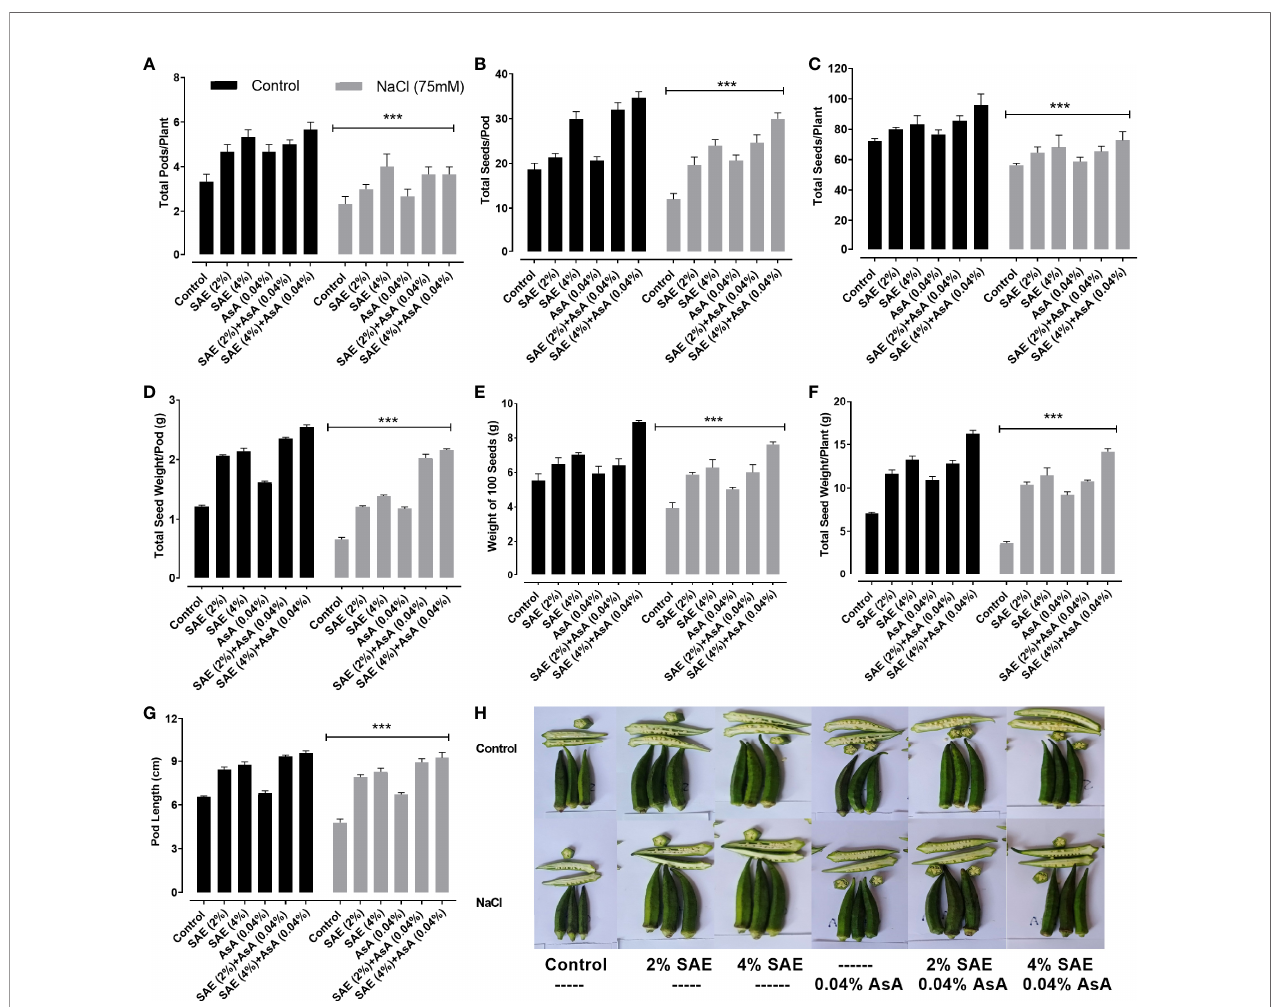
FIGURE 3 | Effect of SAE on different reproductive growth parameters. (A) Total pods/plant; (B) total seed number/pod; (C) total seed number/plant; (D) total seed weight/pod; (E) weight of 100 seeds; (F) total seed weight/plant; (G) average pod length; (H) phenotypes of pods. Error bars of quantitative data represent ± SEM (*** p <